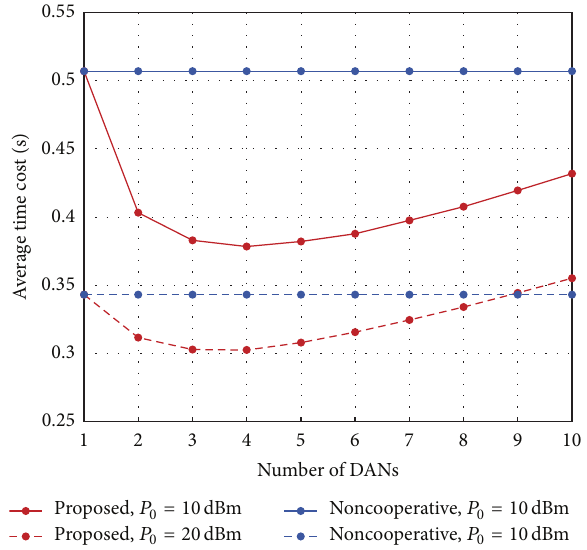
Figure 4: Performance comparison between the proposed and the noncooperative schemes versus different number of DANs ( 𝑀 𝑗 ) with different transmit power ( 𝑃 0 = 10 dBm, 20